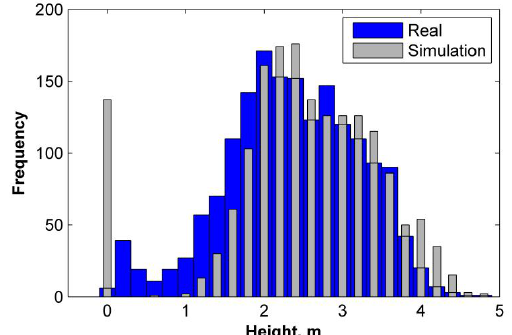
Figure 4. Real and simulated echo height histograms for 2.5– 5-m-high birch trees in the 2010_12_1